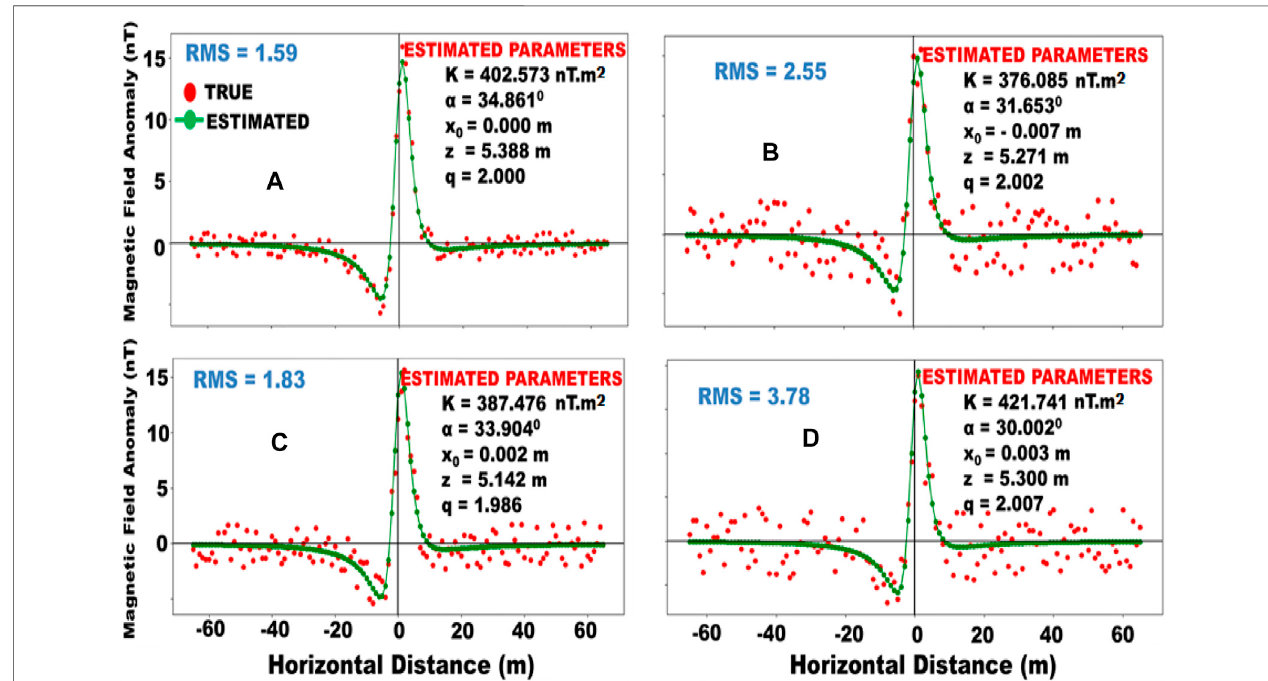
FIGURE5| Syntheticallygeneratednoisyandestimated(MFR)magneticanomaliesforahorizontalcylindermodelwithK=400 nT.m2,z=5 m, α =35,q=2,xo= 0 m, with (A) 5% (B) 10% (C) 15% (D) 20% gaussian random error.